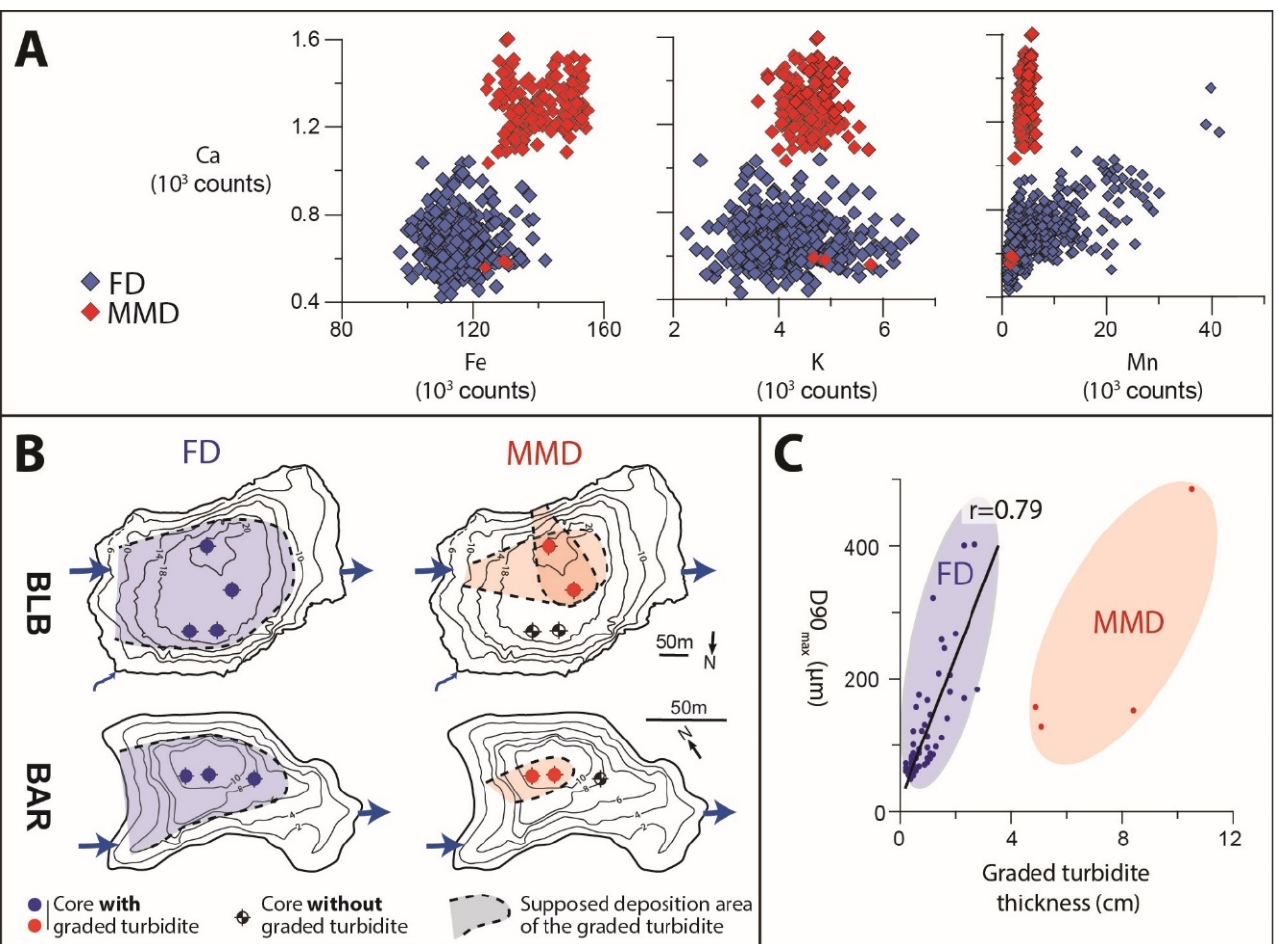
Figure 7. Distinction between flood and mass-movement triggers of event deposits based on ( A ) their geochemical features, ( B ) spatial extent and ( C ) grain size. FD means Flood Deposit and MMD Mass-Movement Deposits. ( A ) XRF analyses of the composition of event layers from Lake Foréant highlight two distinct clusters (one richer in Ca, Fe and slightly in K and one richer in Mn), revealing distinct sediment sources and redox processes that can be respectively associated to either mass movement or flood processes (modified after Wilhelm et al. [39]). ( B ) The set of cores in Lake Blanc Belledonne (BLB) and Blanc Aiguilles Rouges (BAR) allowed reconstructing deposit areas either over a larger part of the basin associated to flood events or restricted to the deepest part of the basin or at the foot of lateral slopes associated to mass movements (modified after Wilhelm et al. [41,43]). Blue arrows show lake inflows and outflows. ( C ) In Lake BAR, the coarsest fraction of the deposit bases (D90max) against the deposit thicknesses reveal different clusters, which, combined to other clues like the spatial pattern, can suggest the potential trigger (modified after Wilhelm et al. [43]).